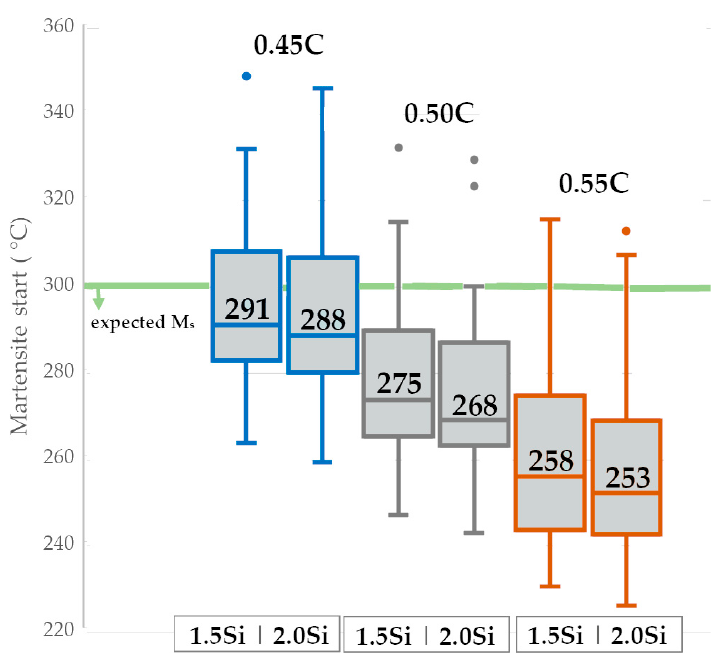
Figure 2. Boxplots of M s temperature in relation to carbon (0.45÷0.55 wt.%) and silicon (1.5 and 2.0 wt.%) content.